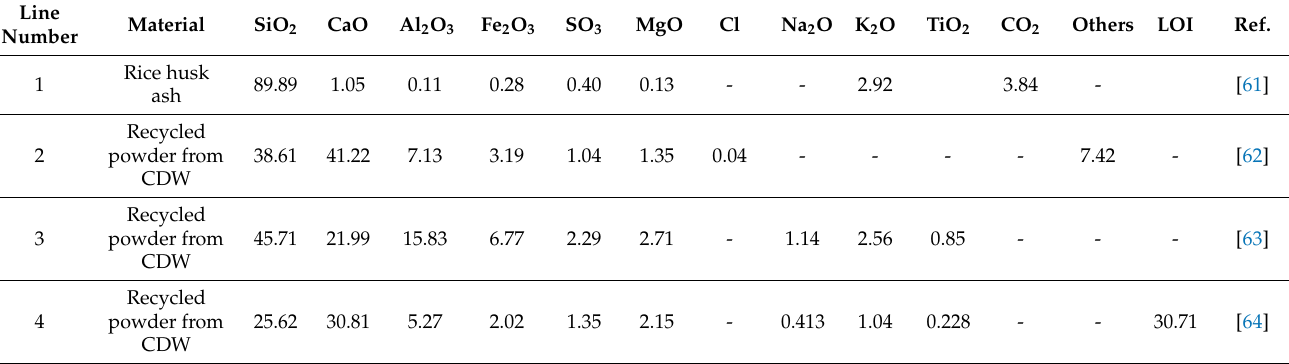
Table 5. Chemical composition of different types of waste or by-products used as unconventional SCM used in 3DPCC